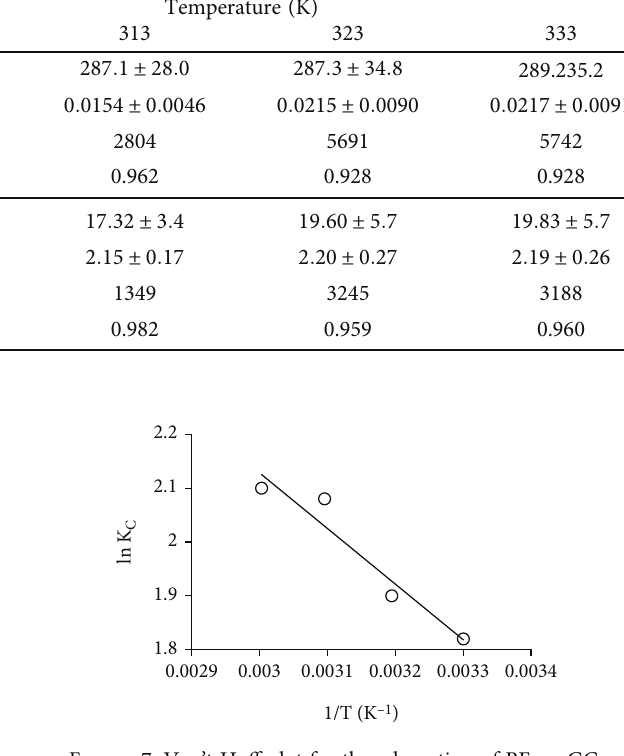
Figure 7: Van ’ t Ho ff plot for the adsorption of BF on